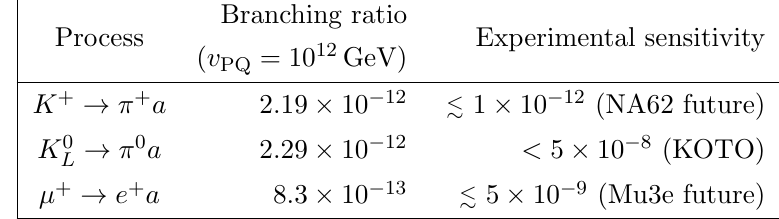
Table 6 . Predictions for axion-induced processes in the A to Z model. Branching ratios are computed assuming v PQ = 10 12 GeV, which should be true up to an O (1) factor. ((cid:1) m ) (cid:24) 10 (cid:0) 23 {10 (cid:0) 24 MeV, while for (cid:22) ! eee the branching ratio is O (10 (cid:0) 45 ), essen- axion P tially